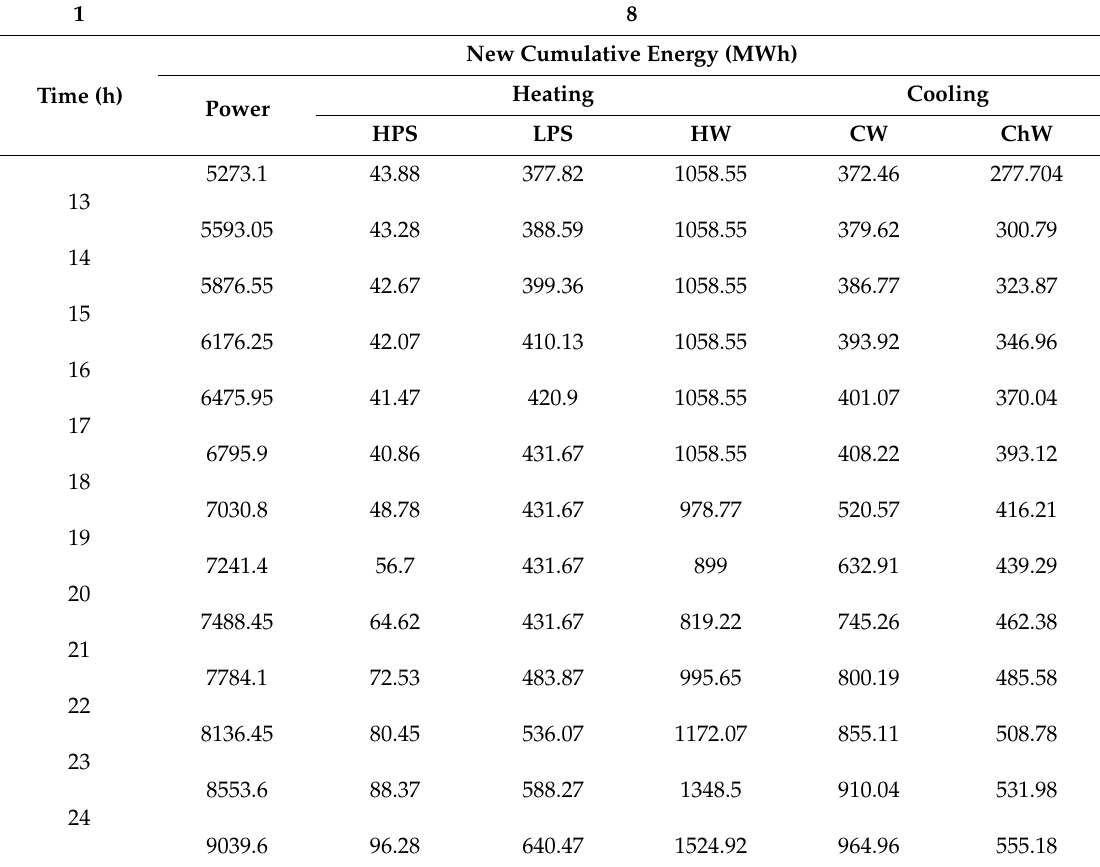
Table A8. TriGenSCA before iteration from 13 to 24 h.